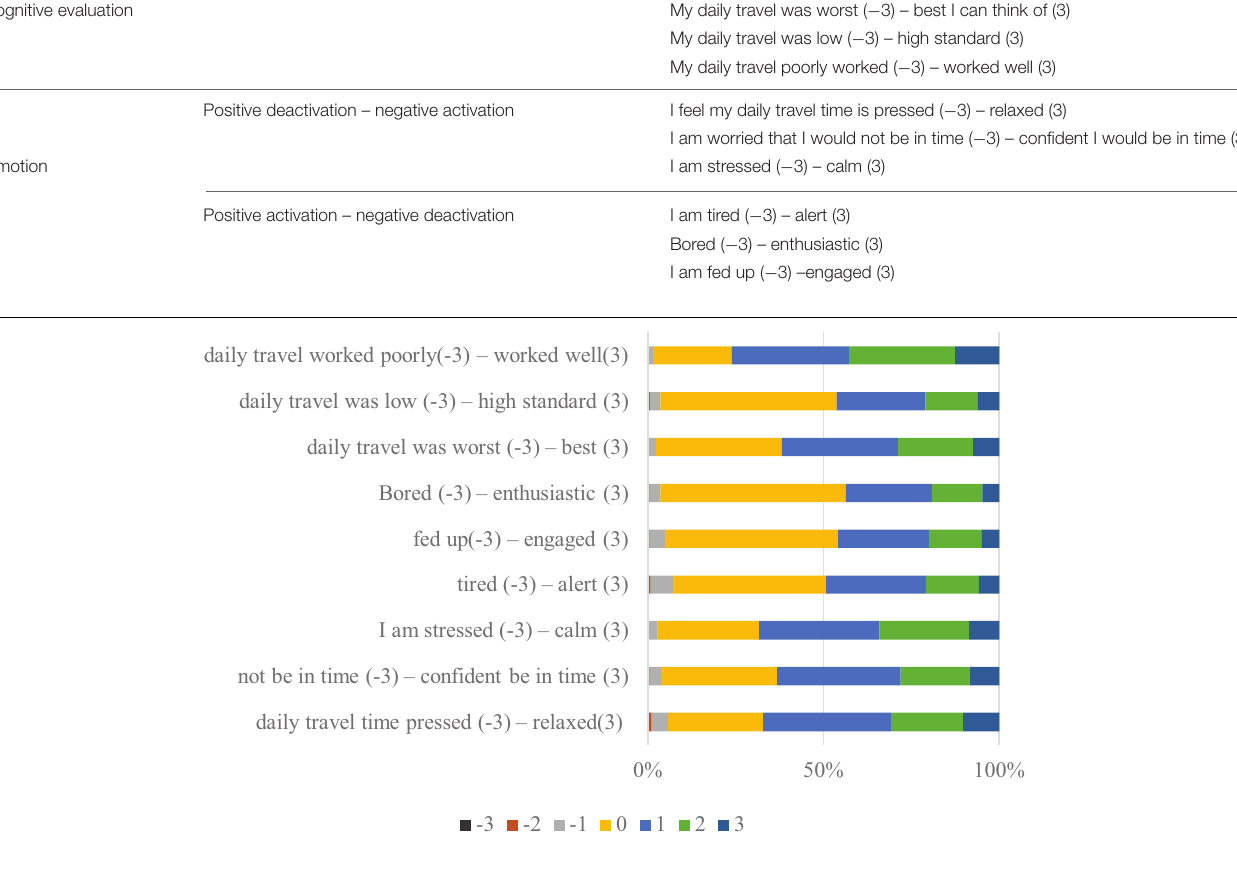
FIGURE 5 | Travel satisfaction